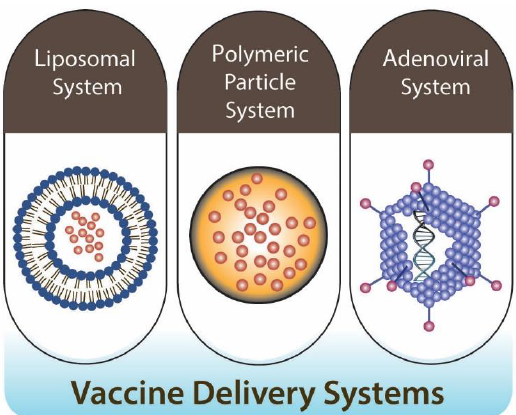
Figure 3. Oral vaccine delivery systems. Design and application of appropriate